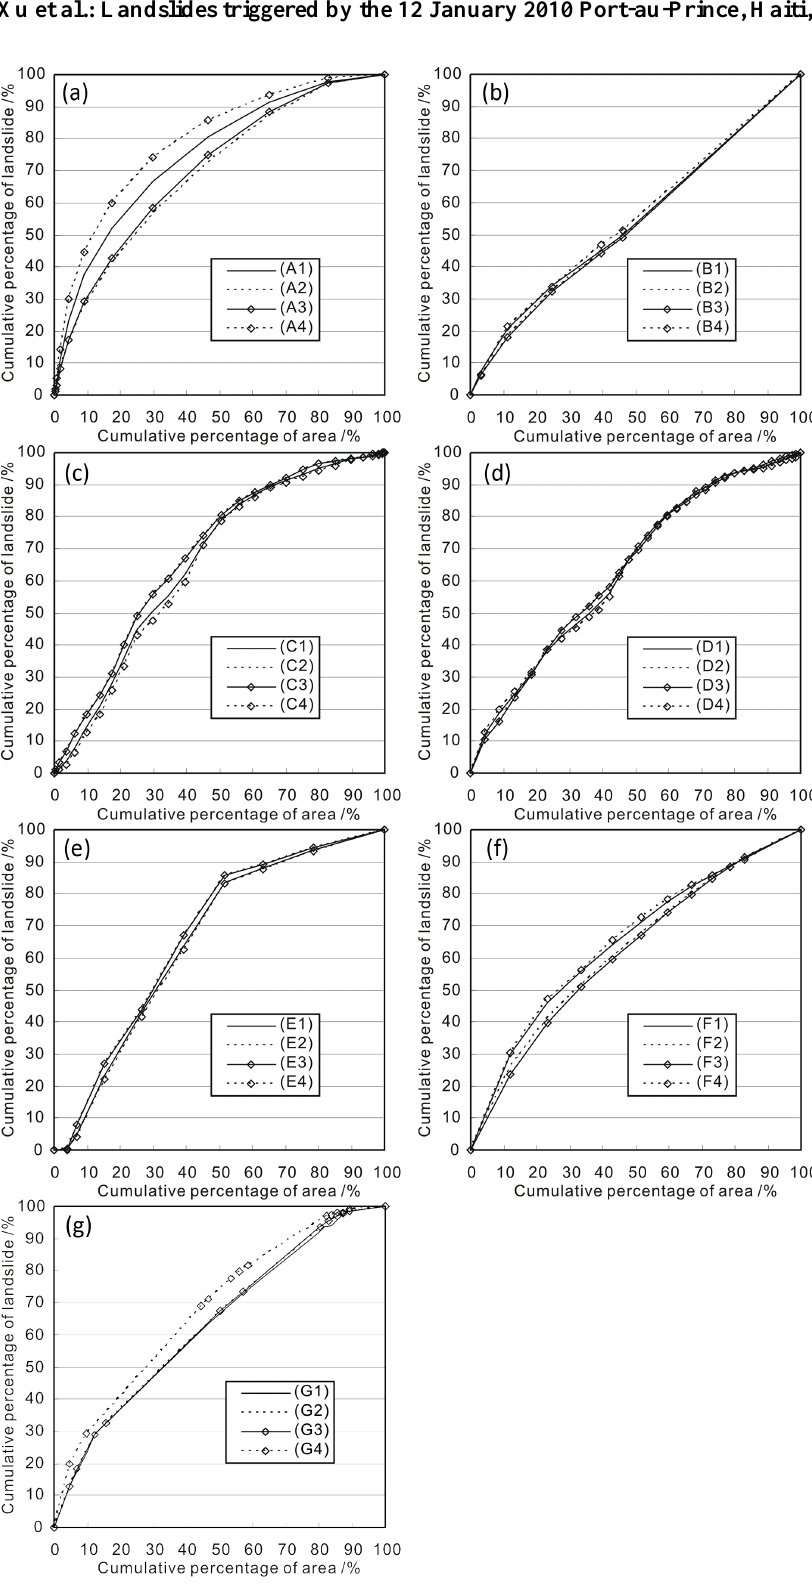
Figure 26. Cumulative landslide area curves to analyze the influence of the seven impact parameters on the landslide occurrences, separately shown by different impact parameters. A: slope angle, B: slope curvature, C: distance from epicenter, D: distance from the Enriquillo– Plantain Garden fault, E: PGA, F: distance from drainages, and G: lithology. The curves are: 1: landslide area, 2: landslide centroid point number, 3: ;and slide top point number, and 4: landslide accumulation material